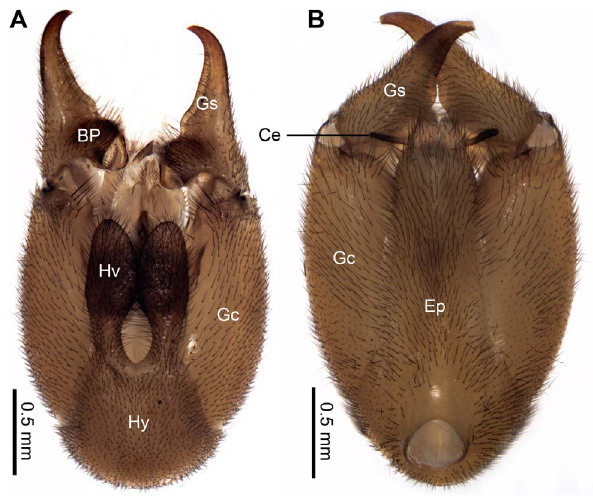
Figure 4. Male genital bulb of N.longiprocessa . (A) Ventral view. (B) Dorsal view. BP, basal process; Ce, cercus; Ep, epandrium; Gc, gonocoxite; Gs, gonostylus; Hv, hypovalve; Hy, hypandrium.